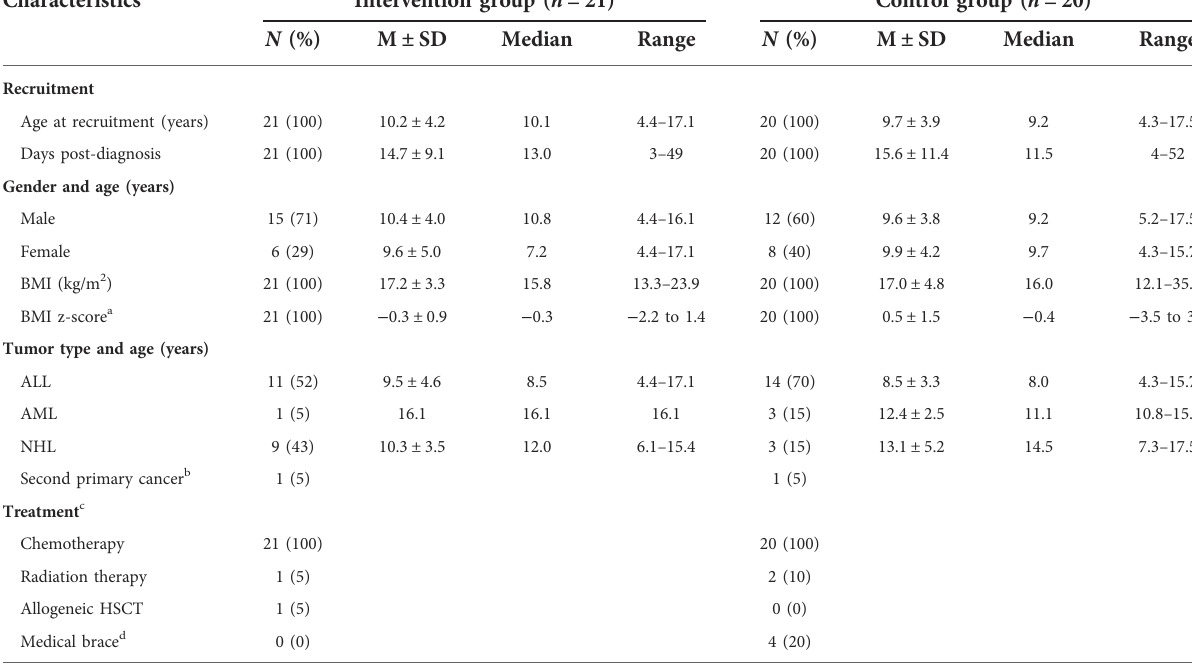
TABLE 2 Participants ’ anthropometric and clinical baseline characteristics by group.